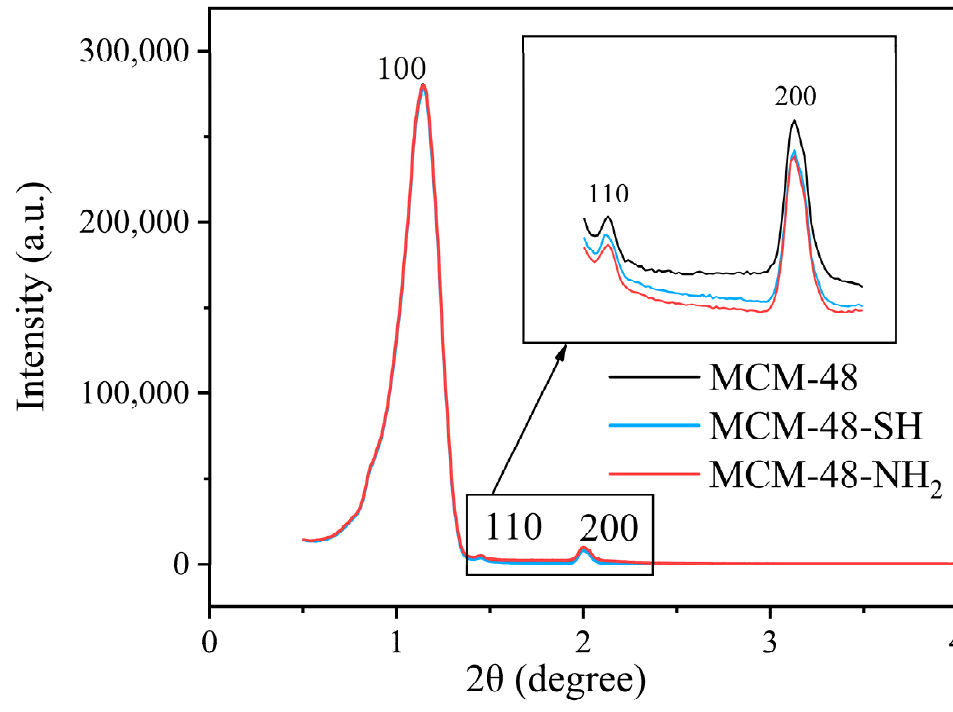
Figure 2. XRD spectra of MCM-48-SH, MCM-48, and MCM-48-NH 2 .